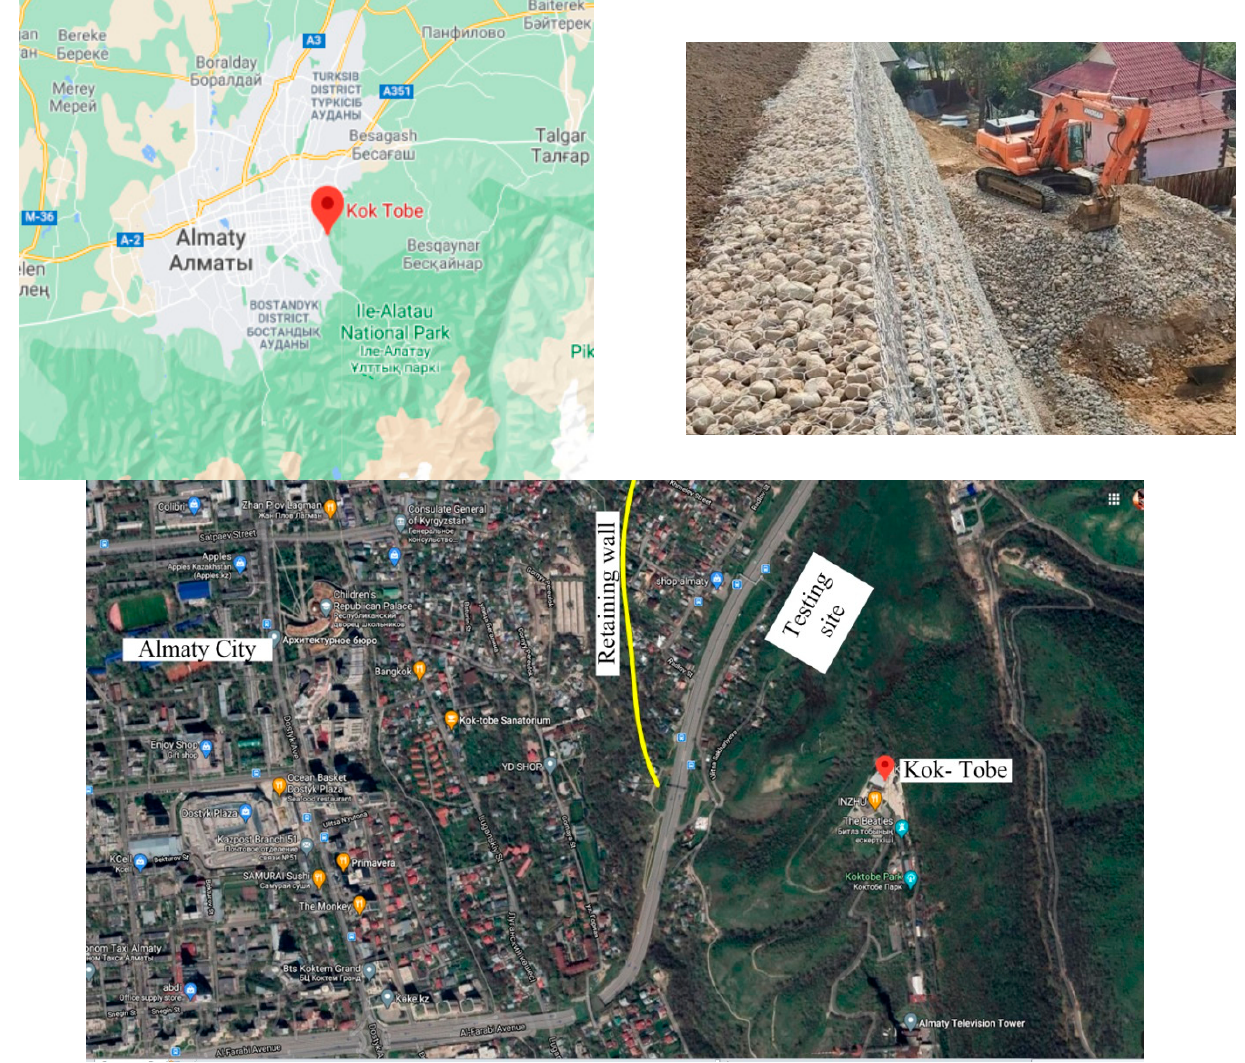
Figure 4. Construction site “Retaining wall on Mount Koktobe” in Almaty. Table 1. Physical and mechanical properties of saline silty-clayey soils test